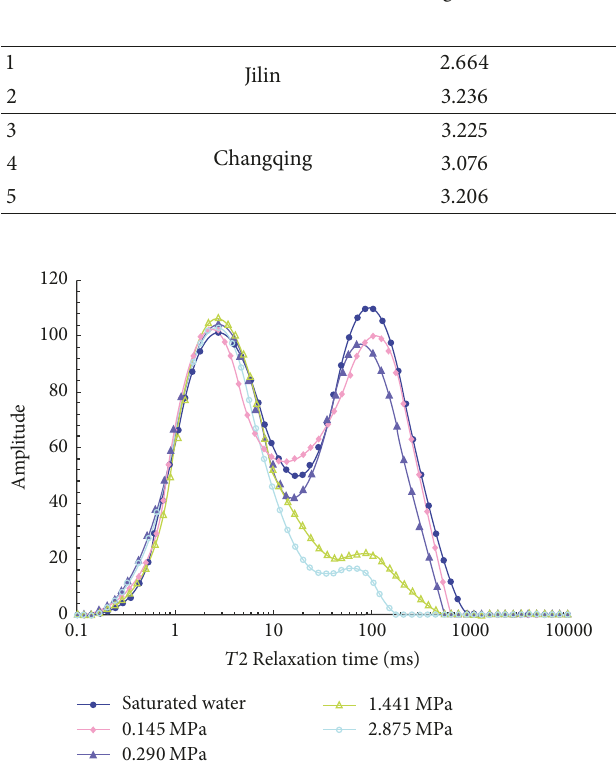
Figure 6: 𝑇 2 spectra of 0.130 mD rock core after centrifugation with different centrifugal pressures.